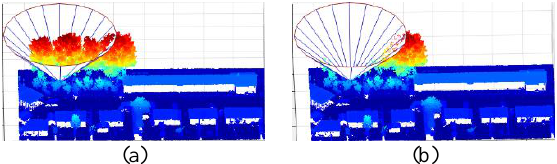
Figure 2 . Tornado method . a) The vertical cone, and b) the